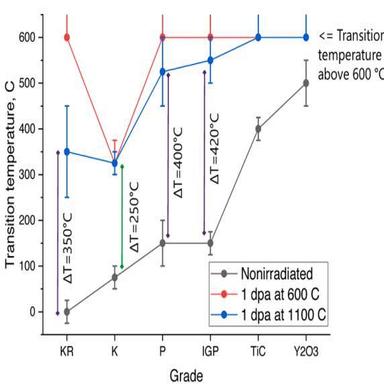
Overview on the DBTT and shift of DBTT. Code: KR=W-Re-K, K=W-K (Tohoku), P=W-K (KIT), IGP=W (Plansee), TiC=PIM W-TiC, Y2O3=PIM W-Y2O3..